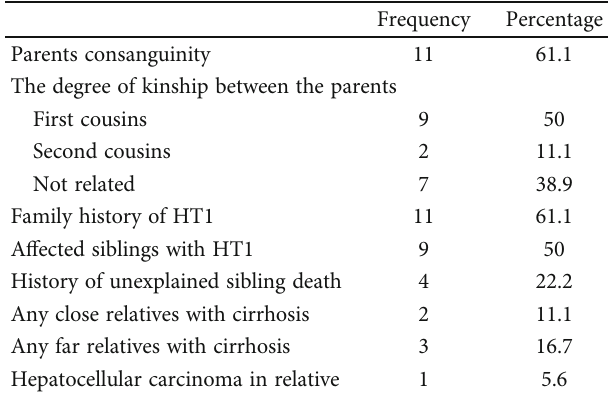
Table 2: Descriptive analysis of the HT1 diagnosed children ’ s family history, N = 18